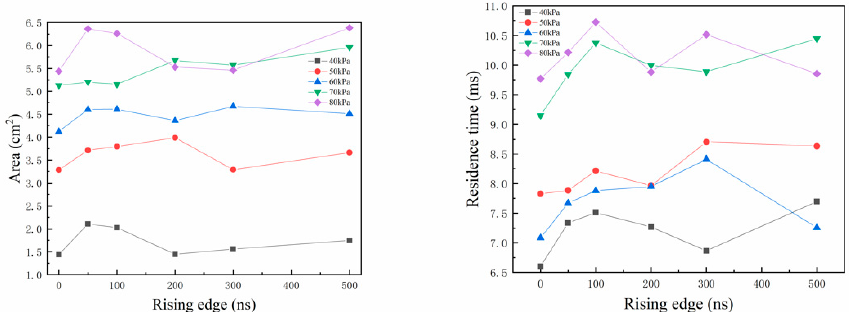
Figure 24. Low-velocity-region areas ( left ) and fuel-air-mixture residence times ( right ) for different pressures and rising-edge times.